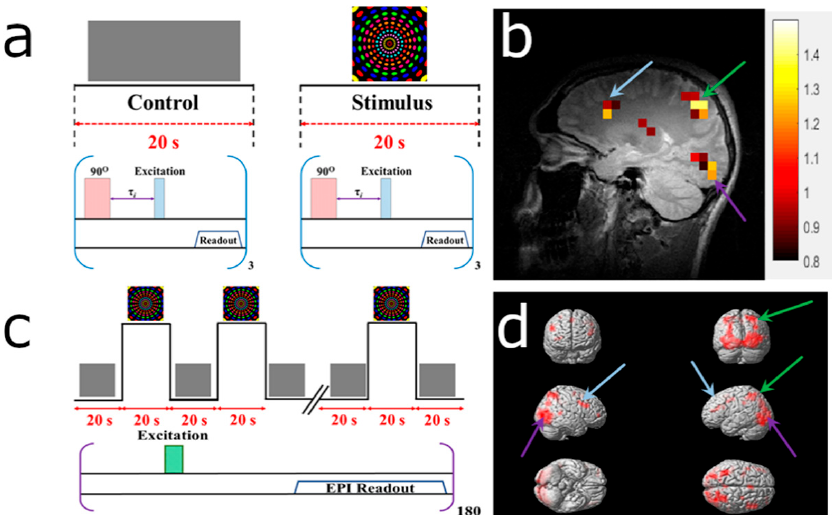
Figure 4. Detection of a hemodynamic response from a colorful visual stimulus using HP 129 Xe perfusion mapping validated by blood oxygenation level-dependent (BOLD) functional brain MRI (fMRI). ( a ) Experimental design used for hemodynamic response detection. Two separate perfusion maps were acquired during the control (gray screen) and visual stimulation. ( b ) Hemodynamic response map created by subtracting the control perfusion map from the stimulated perfusion map and overlaid on top of a high-resolution proton scan. Activation of the occipital lobe, superior parietal lobe, and frontal gyrus was observed. ( c ) BOLD fMRI experimental design for validation of the HP 129 Xe technique. ( d ) BOLD fMRI 3D activation maps demonstrate a correlation with a 129 Xe hemodynamic response map. The activated areas are indicated by colored arrows. The matched activated areas on the Xe image are indicated with arrows of the corresponding